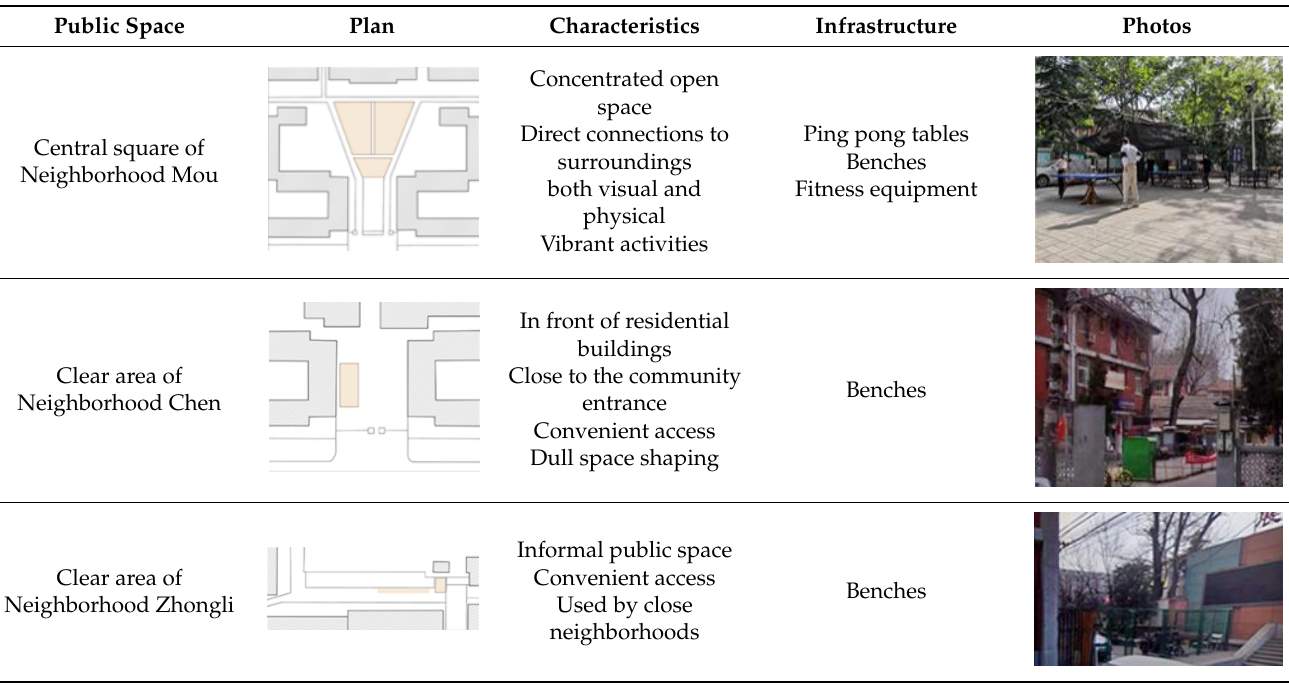
Table 1. Public space observation and mapping of Community Baiwanzhuang.